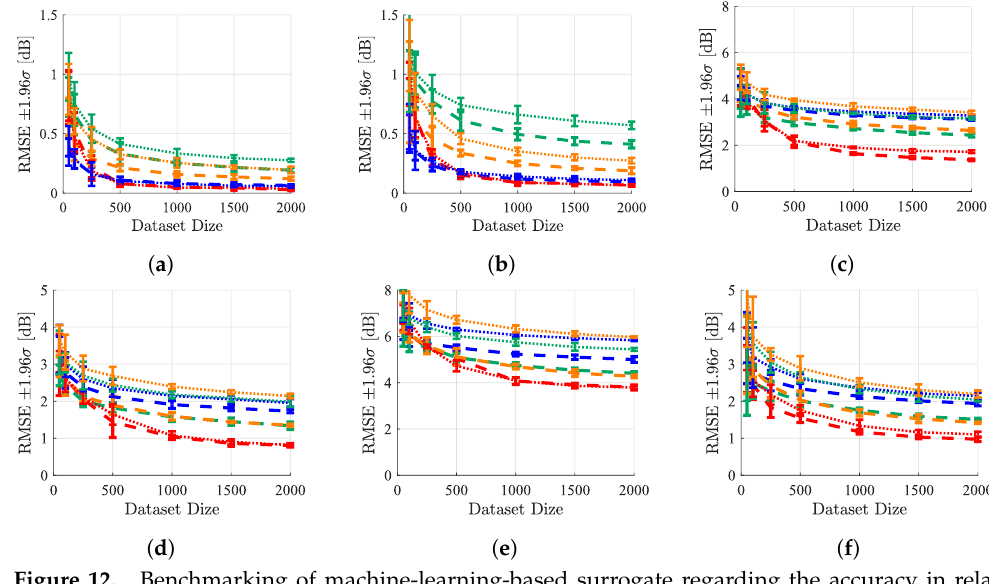
Figure 12. Benchmarking of machine-learning-based surrogate regarding the accuracy in rela- tion to the dataset size: neural network; Gaussian process regressor; random forest; gradient boosting trees; with and without physics-guided features: ( a ) infinite plate; ( b ) correction factor; ( c ) MS; ( d ) MS (band averaged); ( e ) FEM; ( f ) FEM (band averaged).